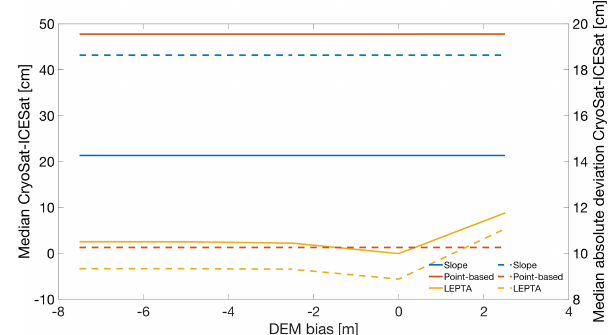
Figure 7. Median of height differences between CryoSat-2 and ICESat-2 ( (cid:49)h calculated with Eq. 16) as a function of the OCOG retracker threshold. Outliers are removed using 10th and 90th per- centiles.